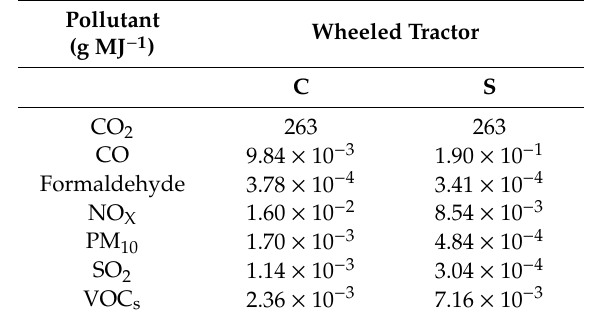
Table 5. Emission factors of compression–ignition engines (C) and spark–ignition engines (S) in wheeled tractorsasrelatedtoengineoutputpower(kgkWh − 1 )[39–41]. ConversionfromkWhtoMJ:1kWh = 3.6MJ; PM10—particular matters up to 10 microns and less; VOCs—volatile organic compounds.